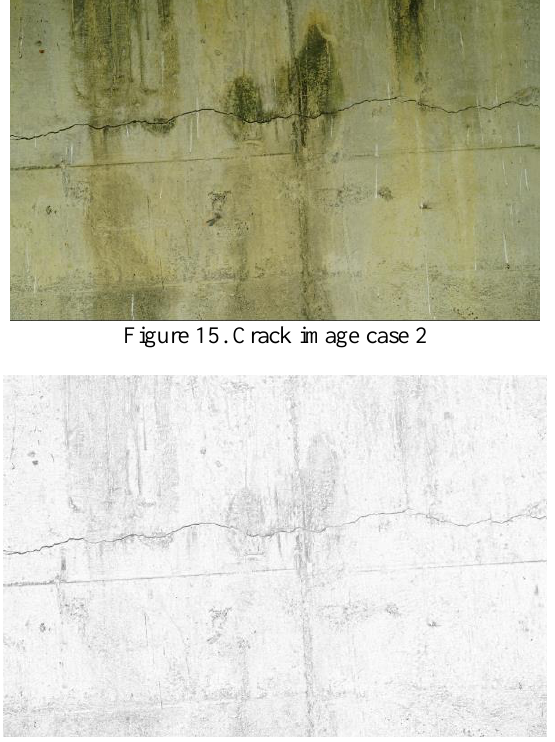
Figure 16. The result after background subtract